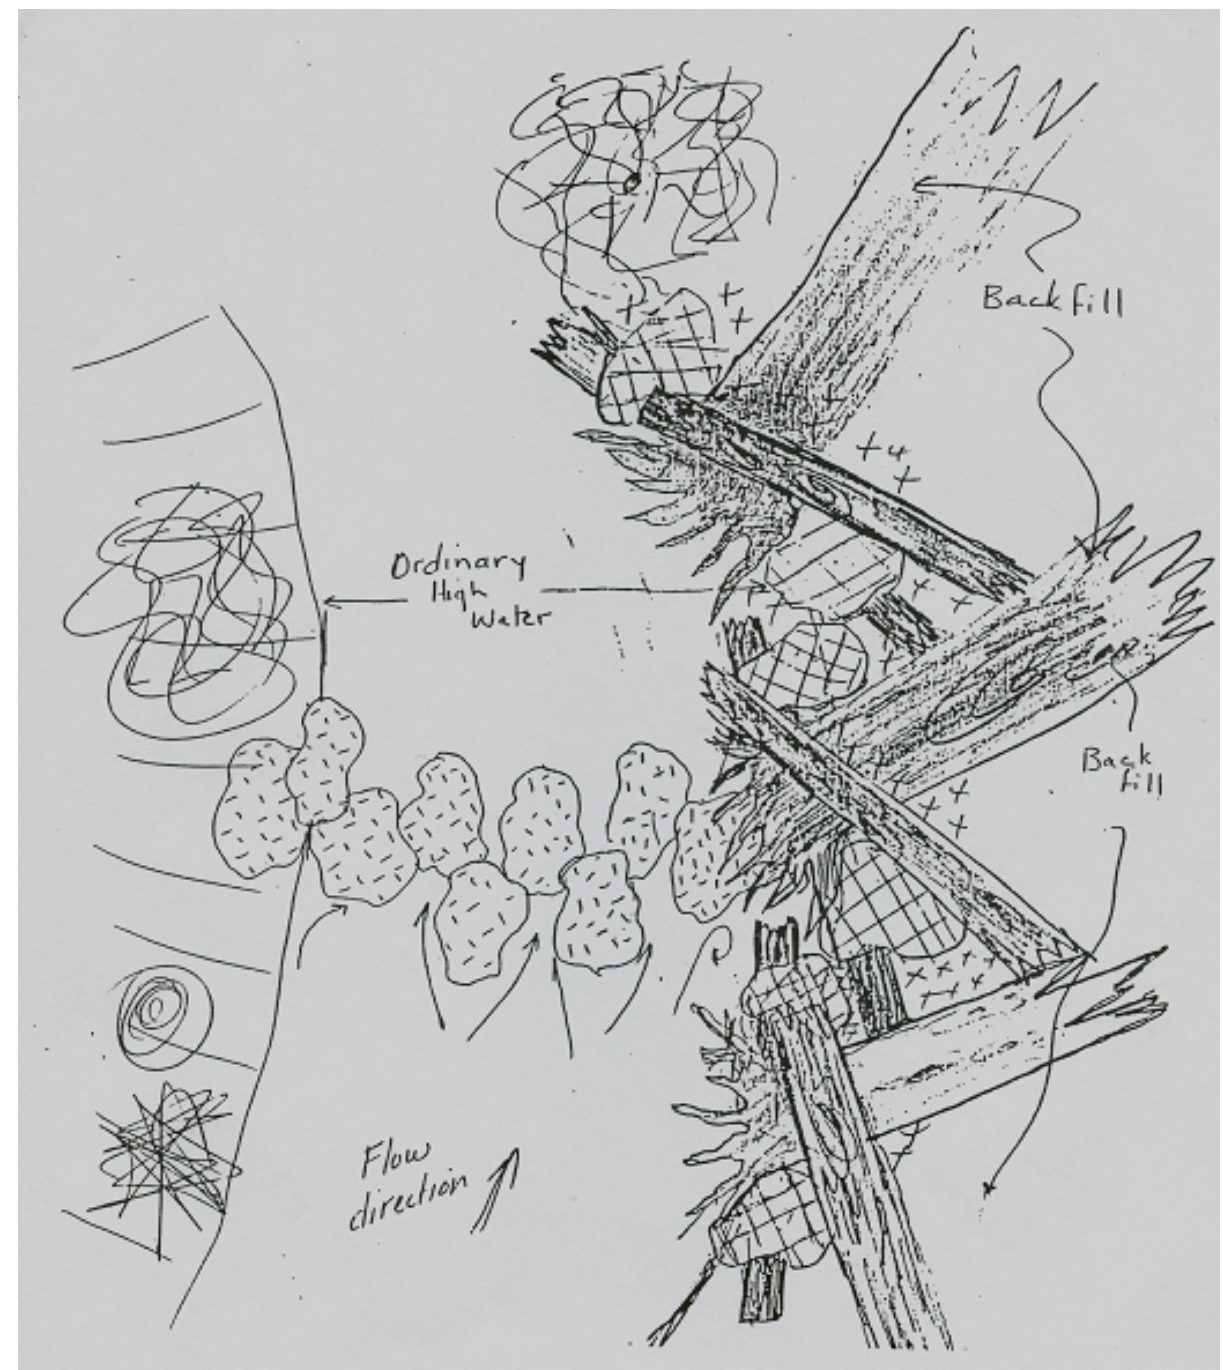
Fig. 1 . Diagram of root wads and boulders to be installed in Cuneo Creek, California (from Rosgen